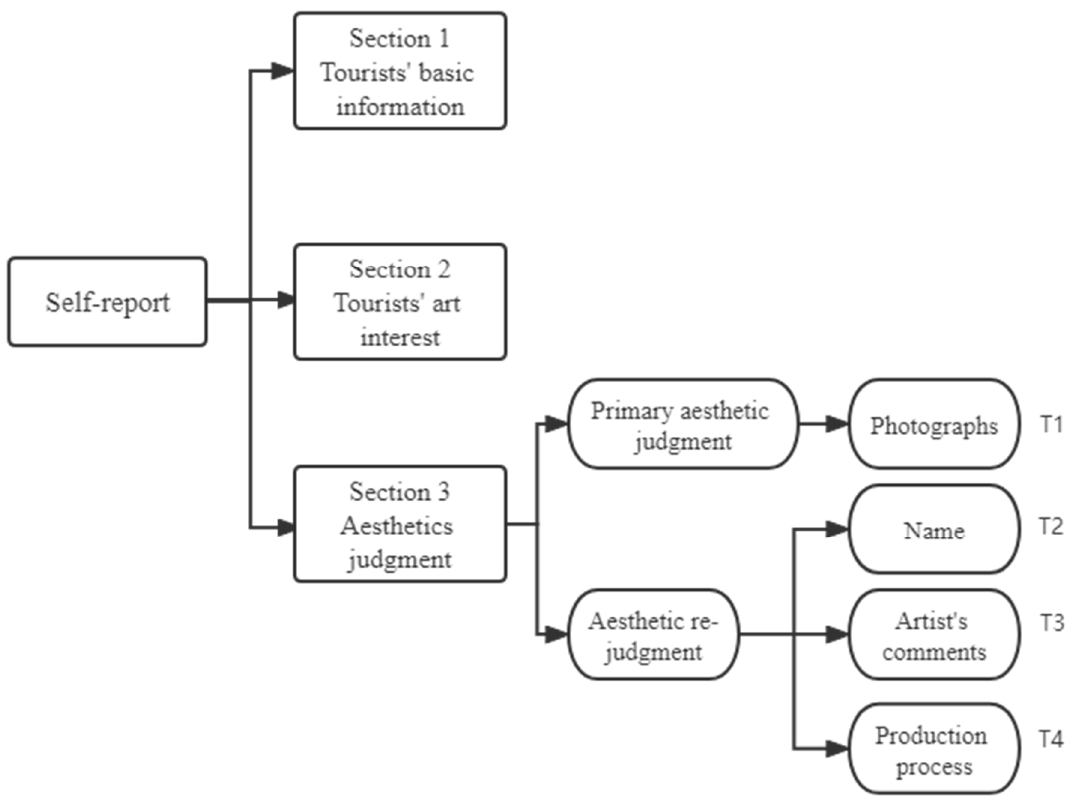
Figure 2. Flowchart of the experiment.